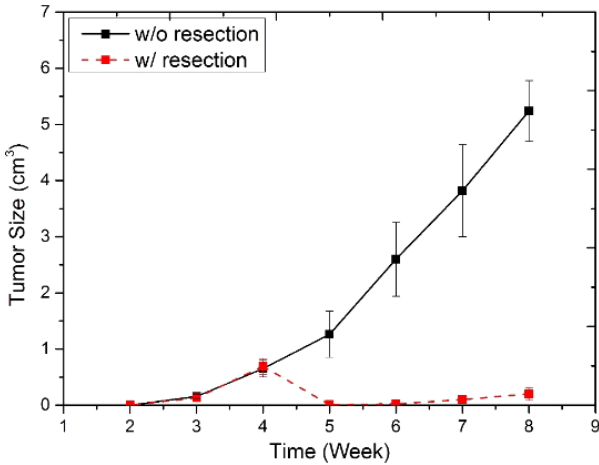
Fig. 5. The comparison of CTC dynamics and tumor growth between a subcutaneous and an orthotopic metastatic tumor model: tumor growth in the subcutaneous and the orthotopic metastatic tumor model. Ultrasound imaging was used to determine the diameters of tumors.